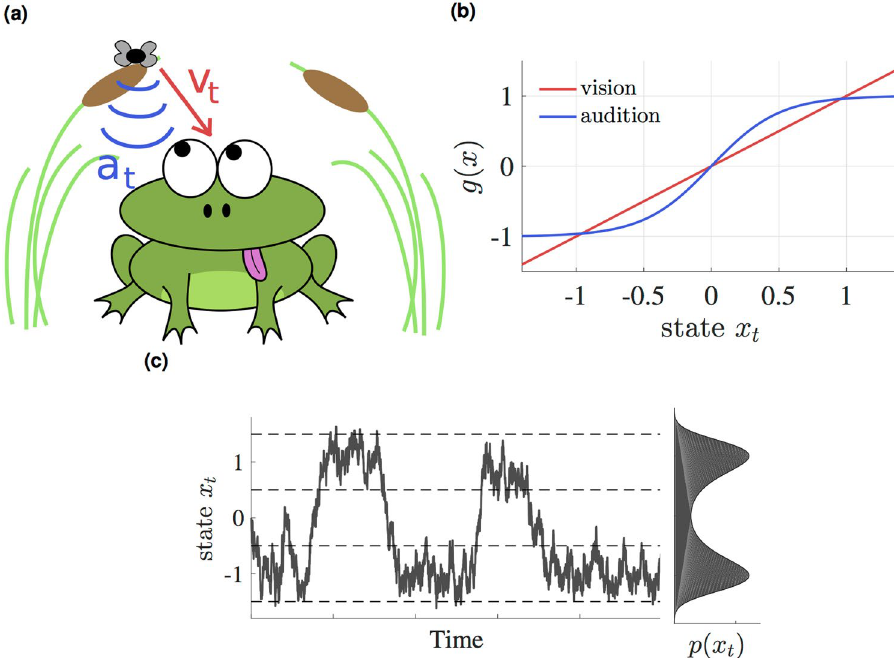
Figure 2. A toy model illustrating the filtering task for perception. ( a ) Cartoon of a frog tracking a fly, relying on its visual ( v t ) and auditory ( a t ) channels. ( b ) Nonlinearities in the generative function g ( x ) of the two sensory channels. Vision is modeled as a linear mapping, while audition is modeled as a sigmoid function. ( c ) A sample trajectory of the fly according to Eq. (15). Note that the nonlinearity in the drift gives rise to a bimodal stationary distribution p ( x t